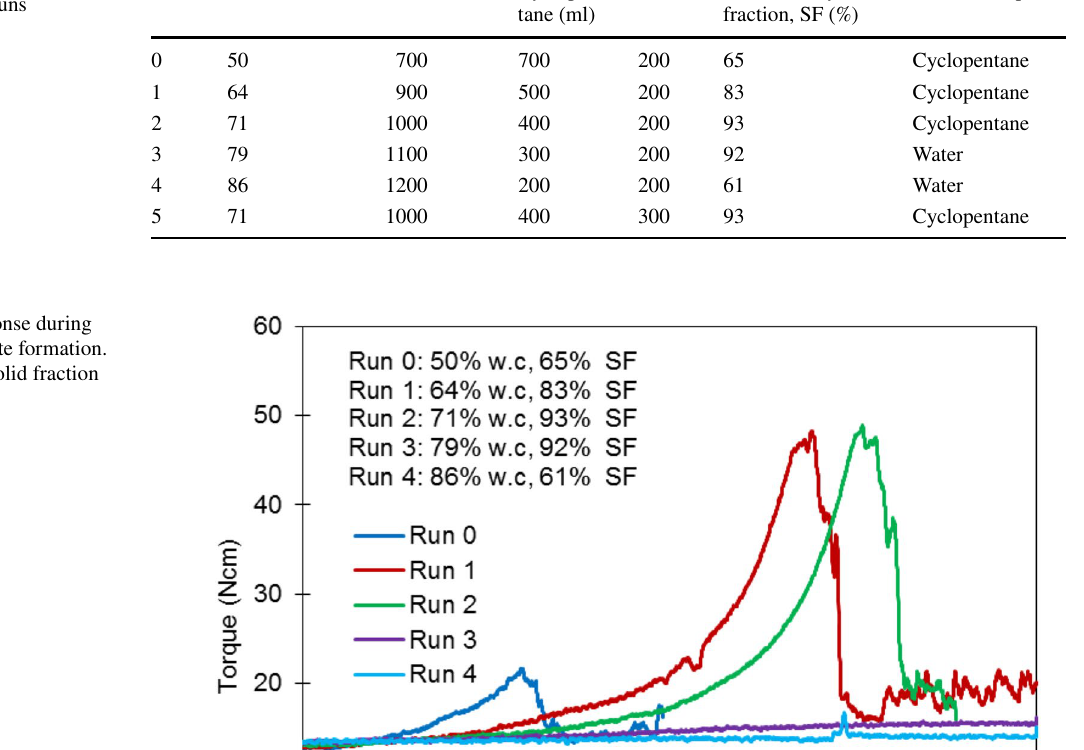
Table 1 Test matrix for the cyclopentane trial runs